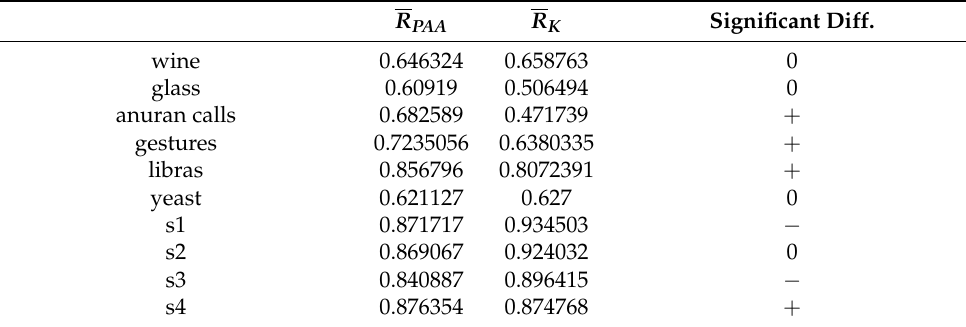
Table 3. Values of Rand index for PAA and K -means and results of the t -test.